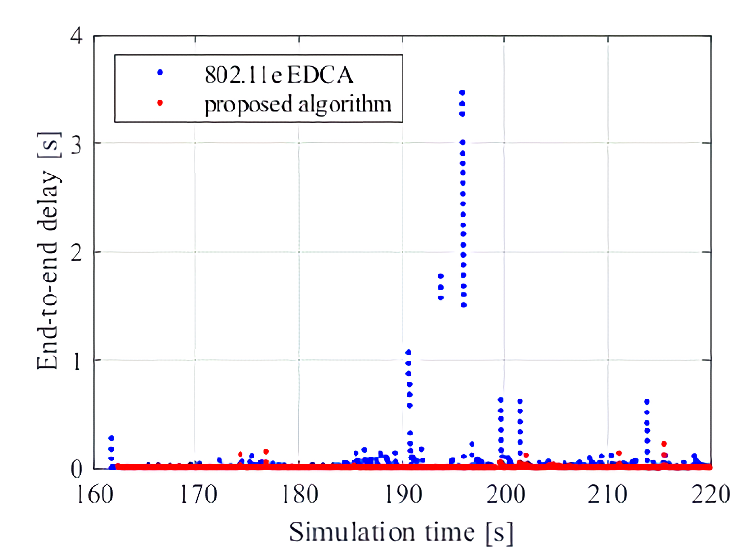
Figure 10. End-to-end delay comparison of video